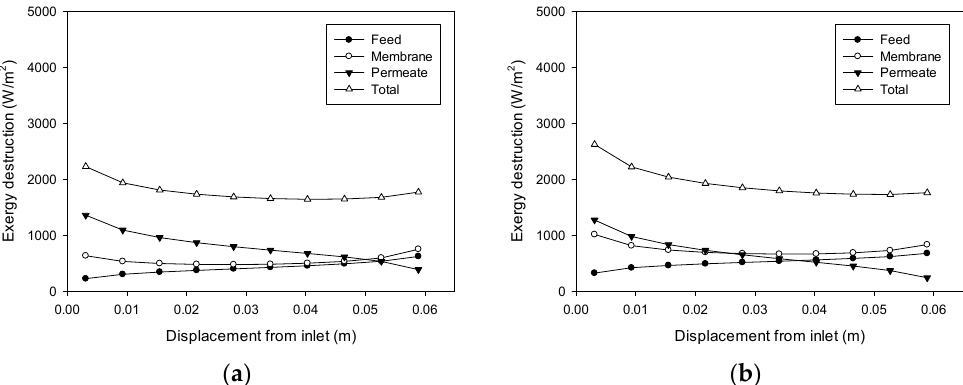
Figure 10. Profiles of exergy destruction in the DCMD module: ( a ) Feed temperature = 60 °C, feed flow rate = 0.6 L/min, and permeate flow rate = 0.2 L/min; ( b ) Feed temperature = 60 °C, feed flow rate = 0.6 L/min, and permeate flow rate = 0.6 L/min.